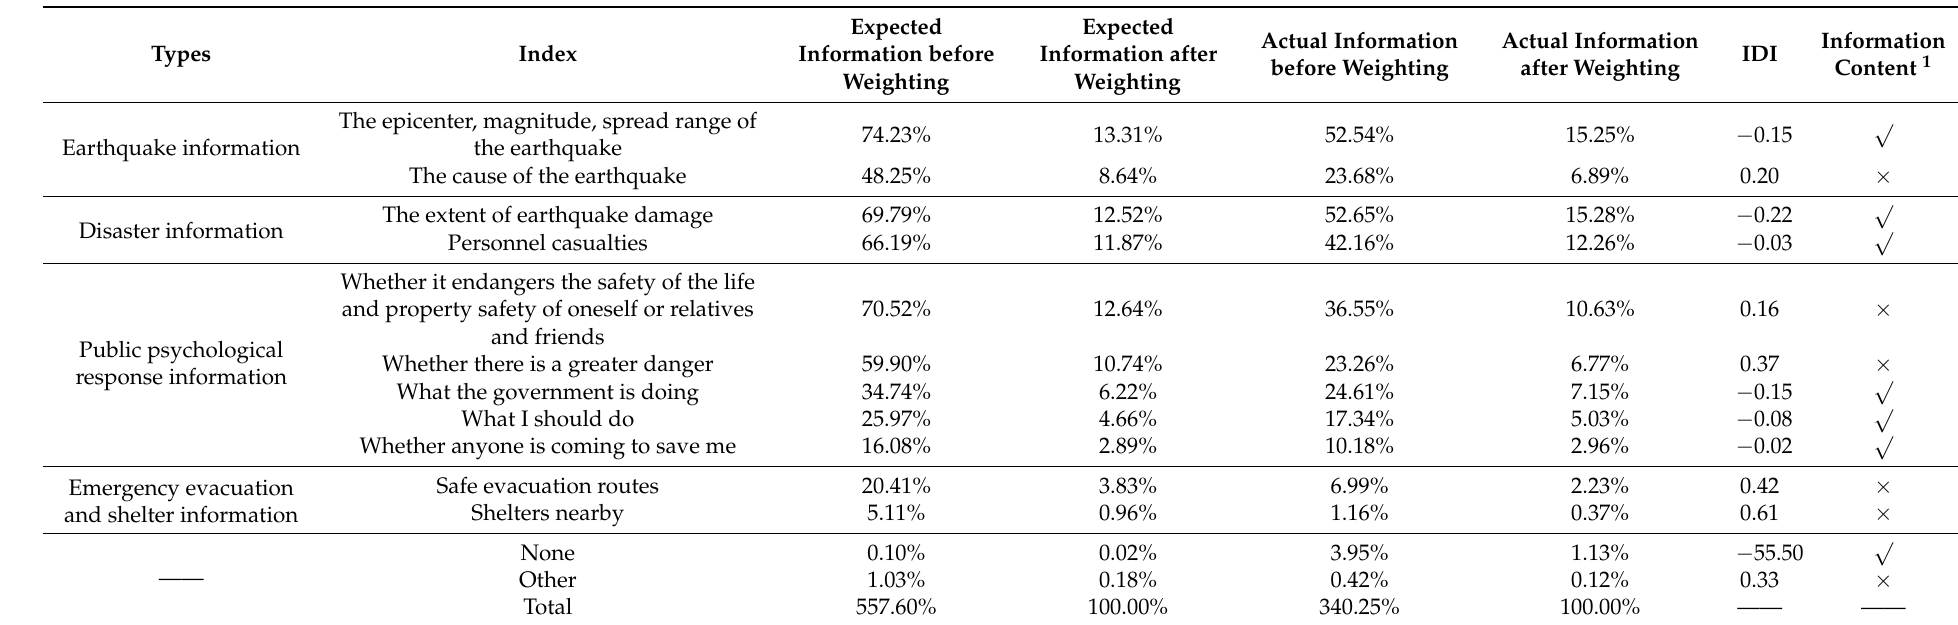
Table 5. Information deviation index in the acute stage of an earthquake